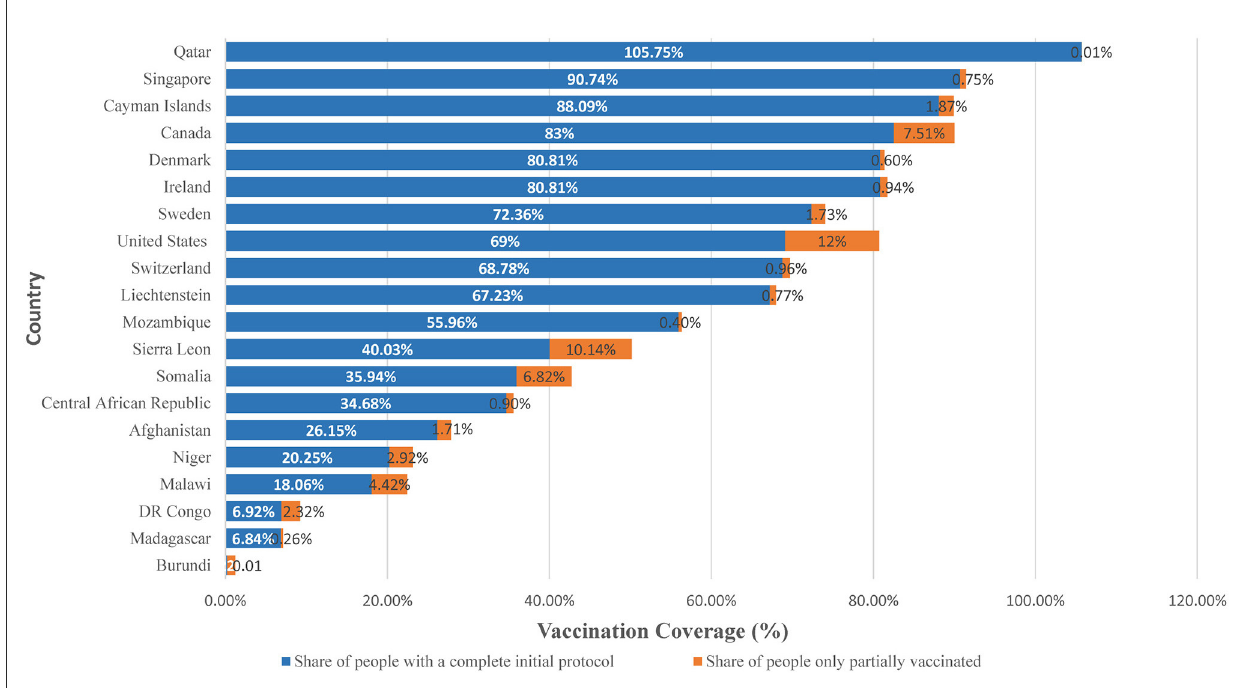
FIGURE1 Share of people vaccinated against COVID-19 vaccine among top 10 HICs and bottom 10 LICs, December 2022. Source: Official data collated by Our World in Data (1).